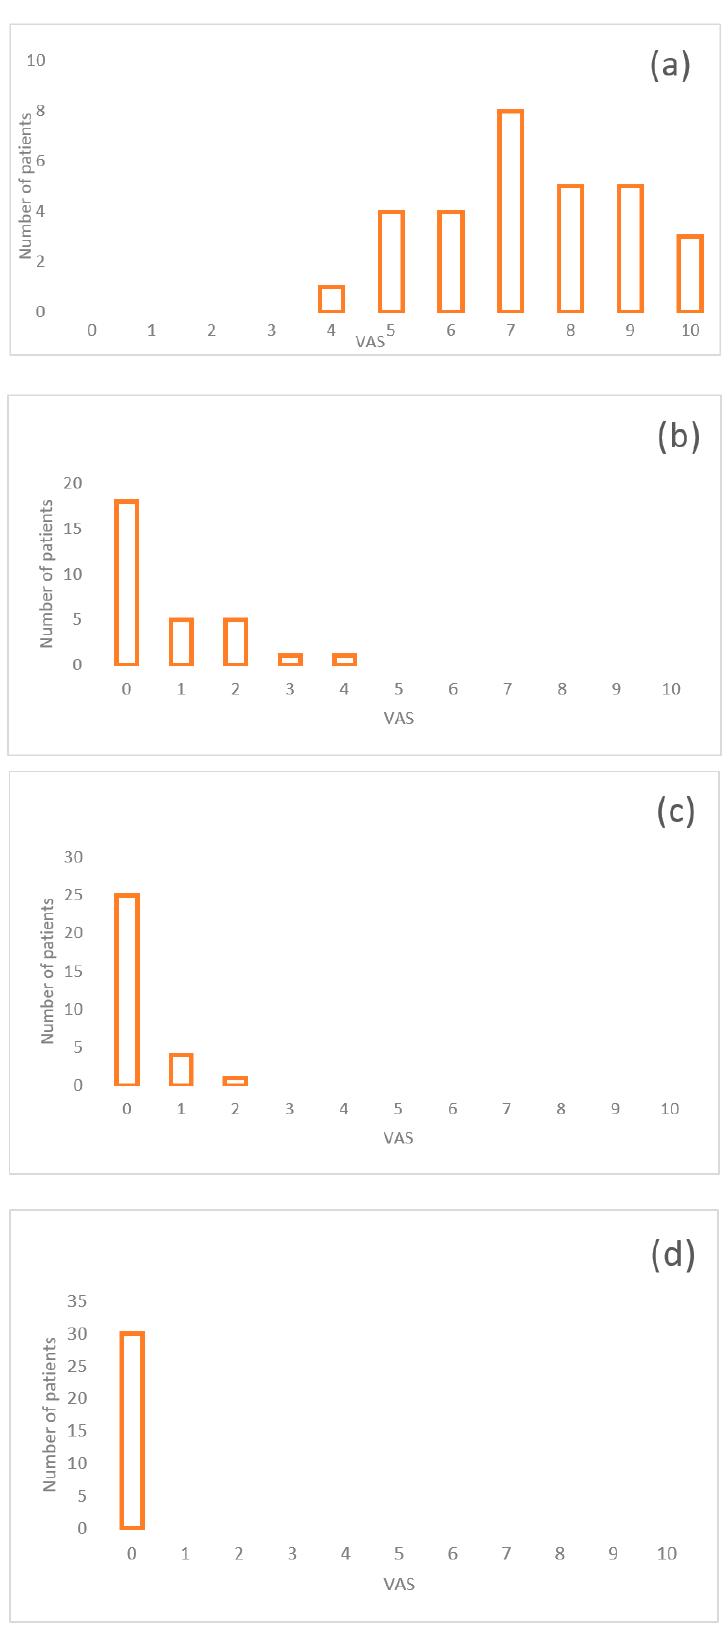
Figure 11. Aesthetic dissatisfaction (VAS) of patients at different time-points: ( a ) t0; ( b ) t1; ( c ) t2; ( d ) t3. Shiff Air Index Sensitive Scale, indicating sensitivity during the treatment, was 0 for all patients at all time-points, except for one patient which reported a value of 3 at all follow-ups, due to periodontal affection. Nineteen patients reported to not have sensitive teeth after treatment (0 value), only 11 patients reported sensitivity (2 value) disappeared within 72 h. All patients answered to be satisfied of the duration of treatment. Satisfaction was scored as follows: 0 in the 3.3% of cases, 6 in the 6.7%, 7 in the 10%, 8 in the 30%, 9 in the 23.3% and 10 in the 26.7% of cases. Concerning to pain during treatment, interviewed answered as follows: 0 in the 56.7% of cases, 1 in the 26.7%, 2 in the 10% and 4 in the 6.7% of cases. The TSIF recorded at t0 were 1 (65.50% of cases), 2 (30.50%), 3 (4.00%), immediately after treatment TSIF was 0 (83.00% of cases), 1 (16.00%), 2 (1.00%). Mean values for dimensions of lesions (mm+/ − SD) were 2.66 mm (1.42) at t0 and 0.32 mm (0.88) at t1. Interclass correlation coefficient (ICC) value was found to be 1 for measurements. Etching cycles needed were ranged between 1 to 13, with the majority of lesions (86%, not gauss-like distribution) having needed 1–7 etching cycles and only a few lesions needed a high number of etching cycles; however, in all case, enamel depletion was noticed. Figure 12 shows the etching cycles performed for each lesion.